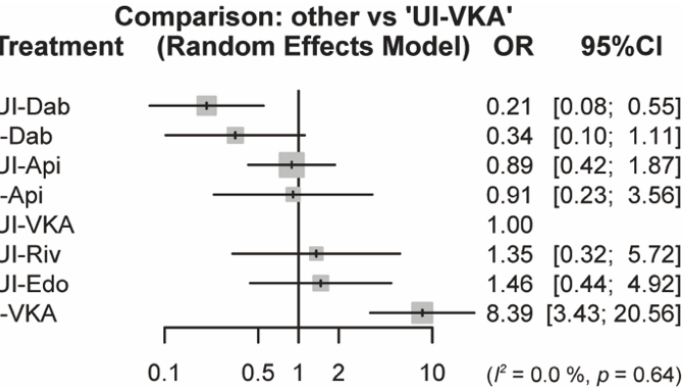
Figure 4. Forest plot for the composite of primary outcomes for each anticoagulant regimen. OR, odds ratio; CI, confidence interval; VKA, vitamin ‐ K antagonist; UI, uninterrupted; I, interrupted; Dab, dabigatran; Api, apixaban; Riv, rivaroxaban; Edo, edoxaban.